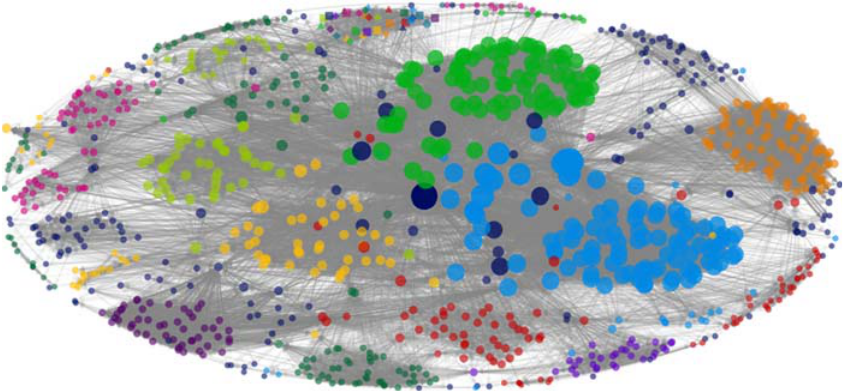
Figure 6. Oficial Maratón de Buenos Aires Facebook fan page graph made with NodeXL from comments generated between August 31, 2015 and October 17, 2015